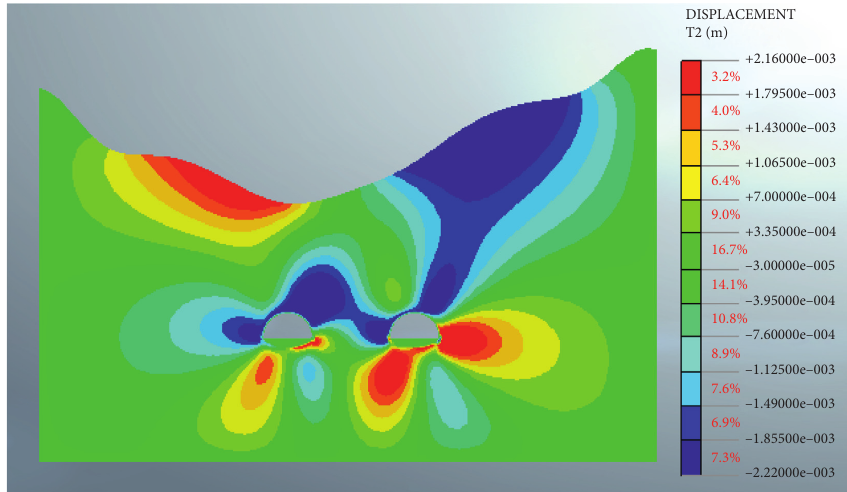
Figure 28: Horizontal displacement distribution of surrounding rock by three-step method.